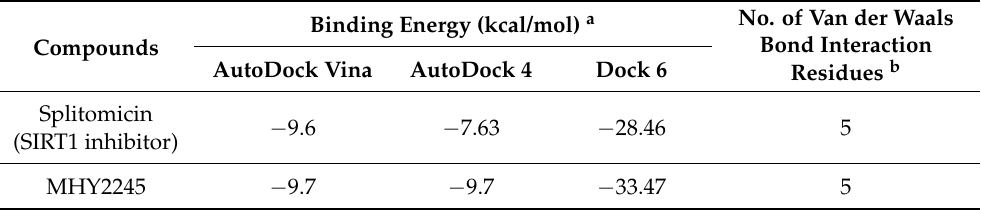
Table 1. Docking simulation to identify the interactions between the ligand binding domains of SIRT1 and MHY2245.